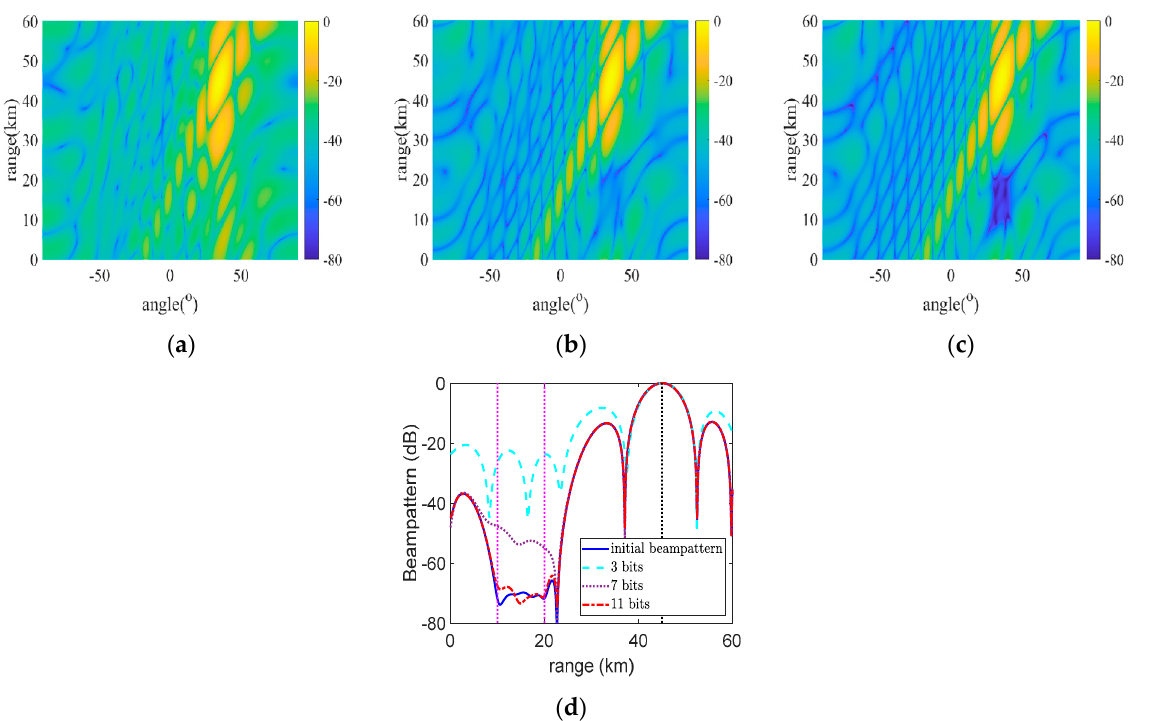
Figure 12. The constant modulus decomposition SNBC beampattern on different quantization bits: ( a ) 3 bits, ( b ) 7 bits, ( c ) 11 bits, ( d ) cross–section of different quantization at target angle.